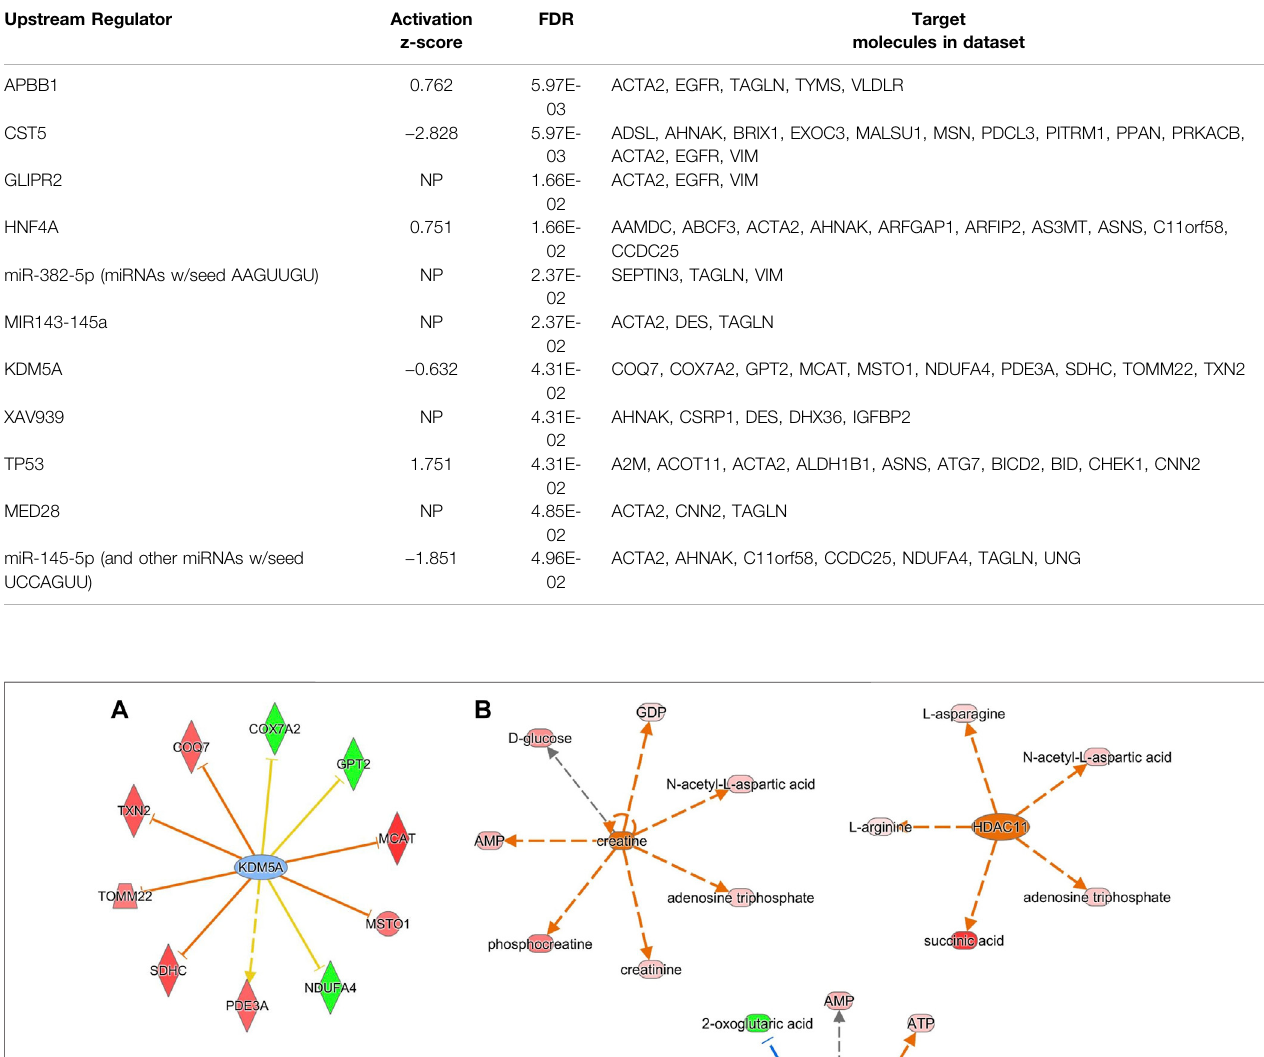
TABLE 3 | Analysis of upstream regulators generated from protein changes between MitoPPX and Wt cells identi fi ed using IPA software. The 11 predicted upstream regulatorswithanFDRsetat0.05arelistedbelow.Theactivationz-scorecanbeusedtoinferlikelyactivationstatesoftheupstreamregulatorsbasedonthedirectionof protein abundance change in the dataset, i.e. a negative activation z score indicates that the upstream regulator is downregulated in MitoPPX cells compared to Wt. NP indicates no prediction of activation status was generated by the IPA